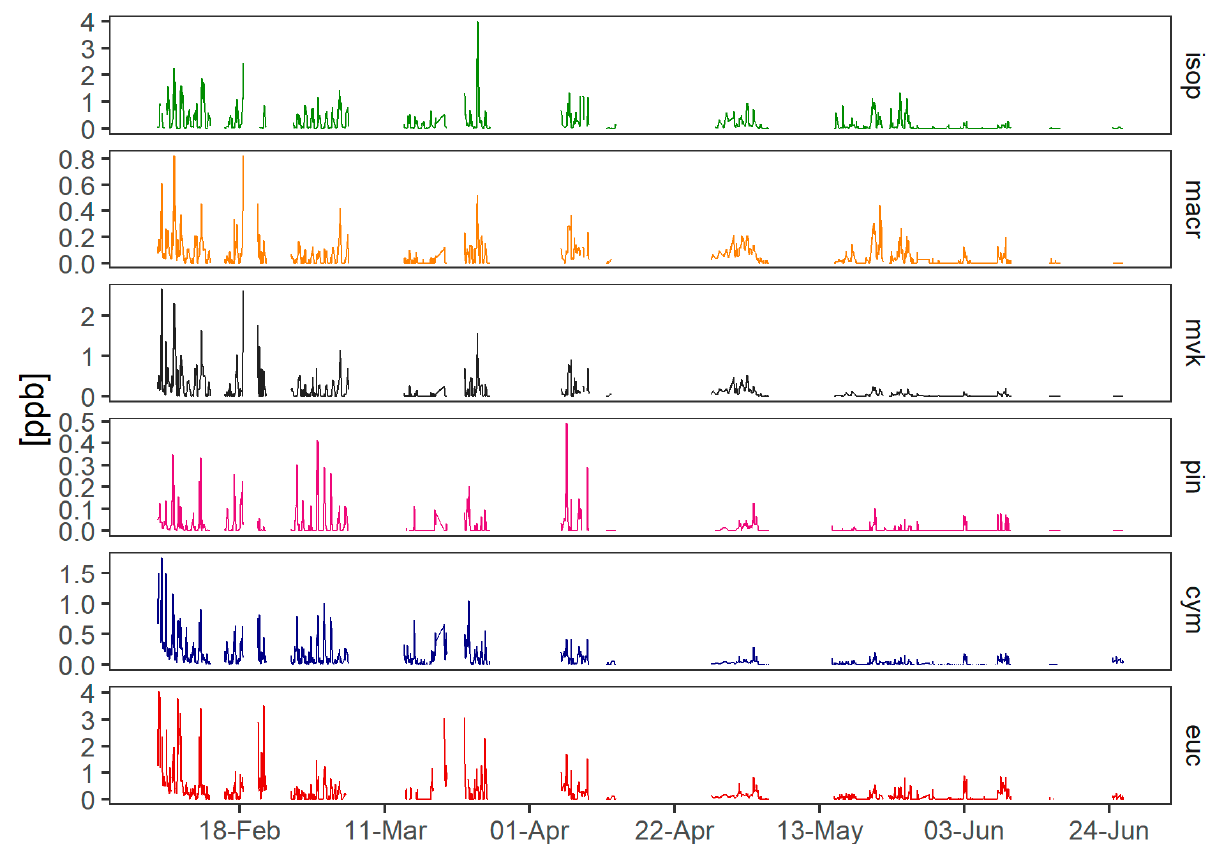
Figure 4. Timeseries of BVOCs measured at the ANSTO site using the BAASS, where isop = isoprene, macr = methacrolein, mvk = methyl-vinyl-ketone, pin = α -pinene, cym = p-cymene and euc = eucalyptol. The instrument was malfunctioning during most of April due to contamination in the system.